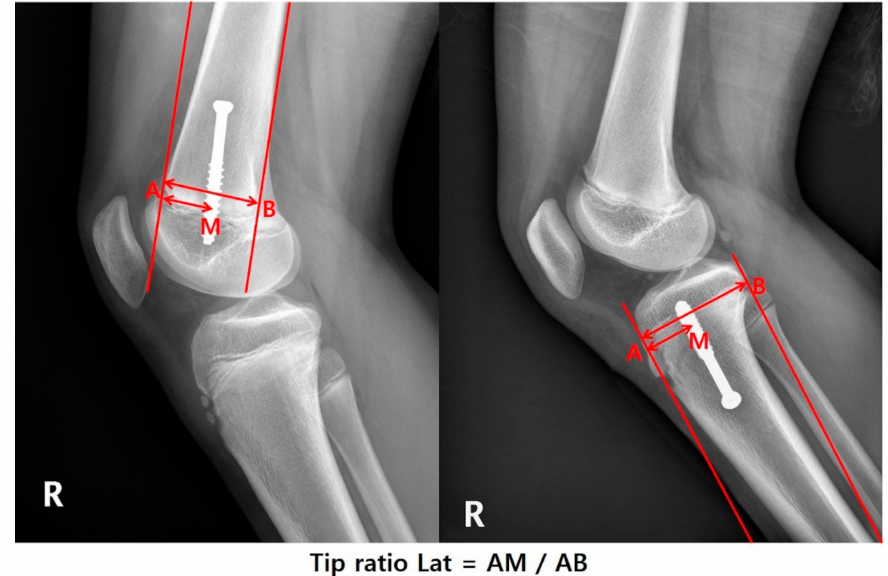
Figure 2. On the knee lateral view, the screw position was determined as the ratio of AM (distance from center to screw) and AB (distance of half physis). This ratio was named “Tip ratio Lat.”. Anatomical tibiofemoral angle (aTFA), mechanical axis deviation (MAD; Figure 3), anatomical lateral distal femoral angle (aLDFA) and anatomical medial proximal tibial angle (aMPTA) were measured in teleroentgenograms taken before PETS surgery and before screw removal. The aTFA is the angle formed by the intersection of the mechanical axes of the femur and the tibia, and the MAD is the ratio of the width of the tibial articular surface that the mechanical axis line crosses. These terms are defined as such to avoid errors of magnification [14]. A value greater than 50% indicated a varus alignment. In comparison, a value of less than 50% indicated a valgus alignment of the knee with lateralization of the mechanical axis.